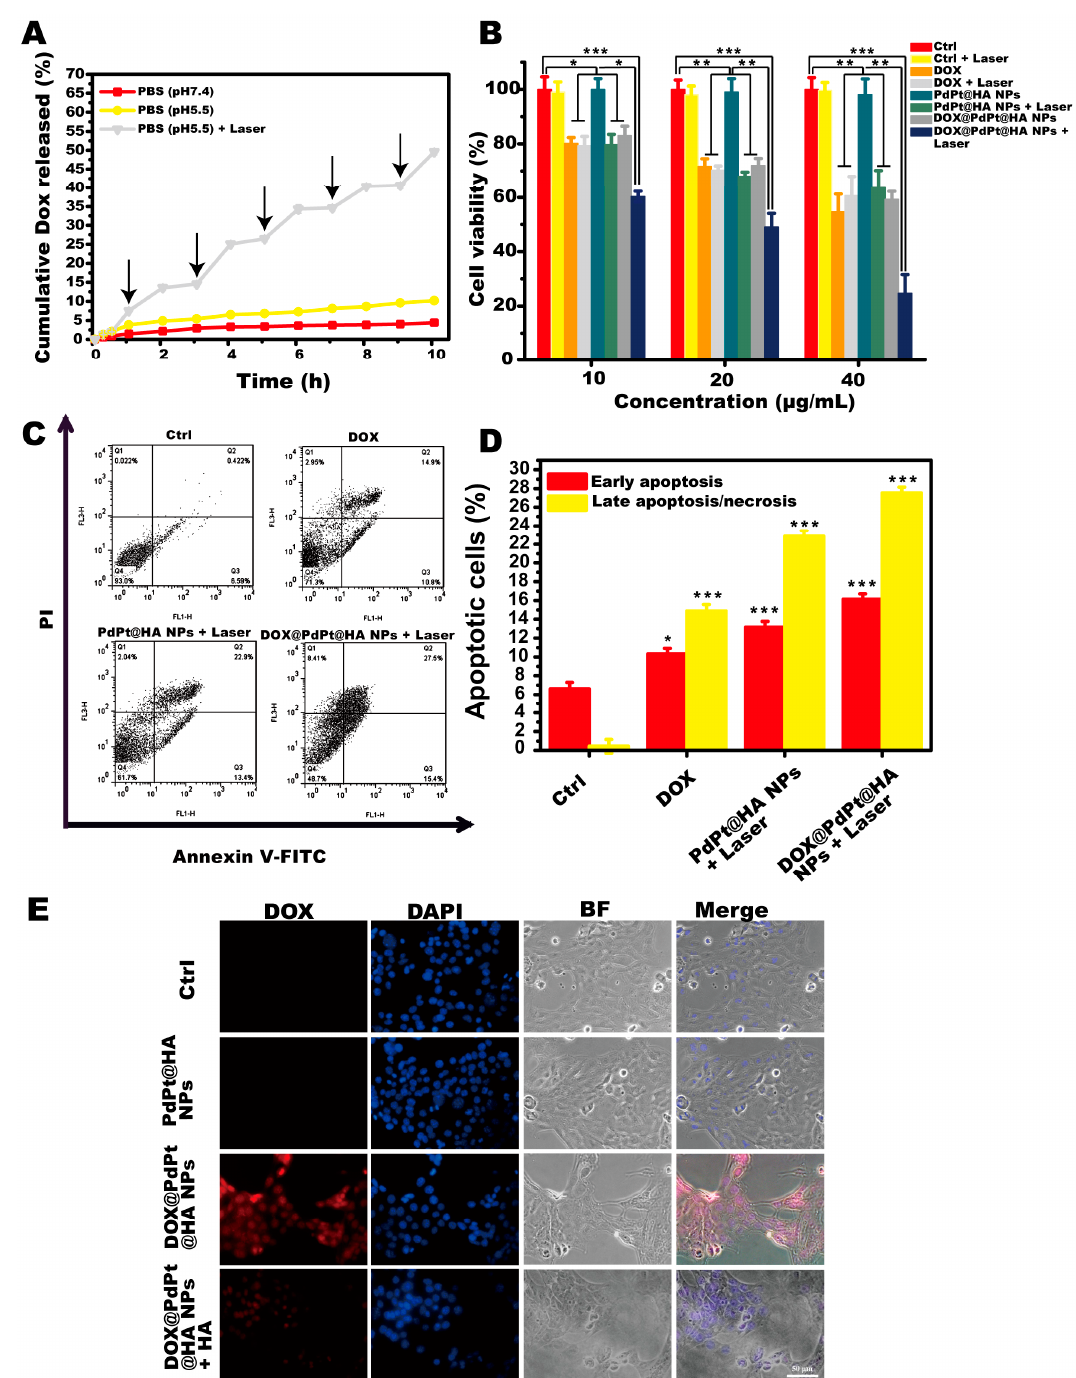
Figure 3. DOX release behaviors and in vitro cytotoxicity of DOX@PdPt@HA NPs. ( A ) NIR laser irradiation triggers release of DOX from DOX@PdPt@HA NPs. ( B ) Cell viability of 4T1 cells treated